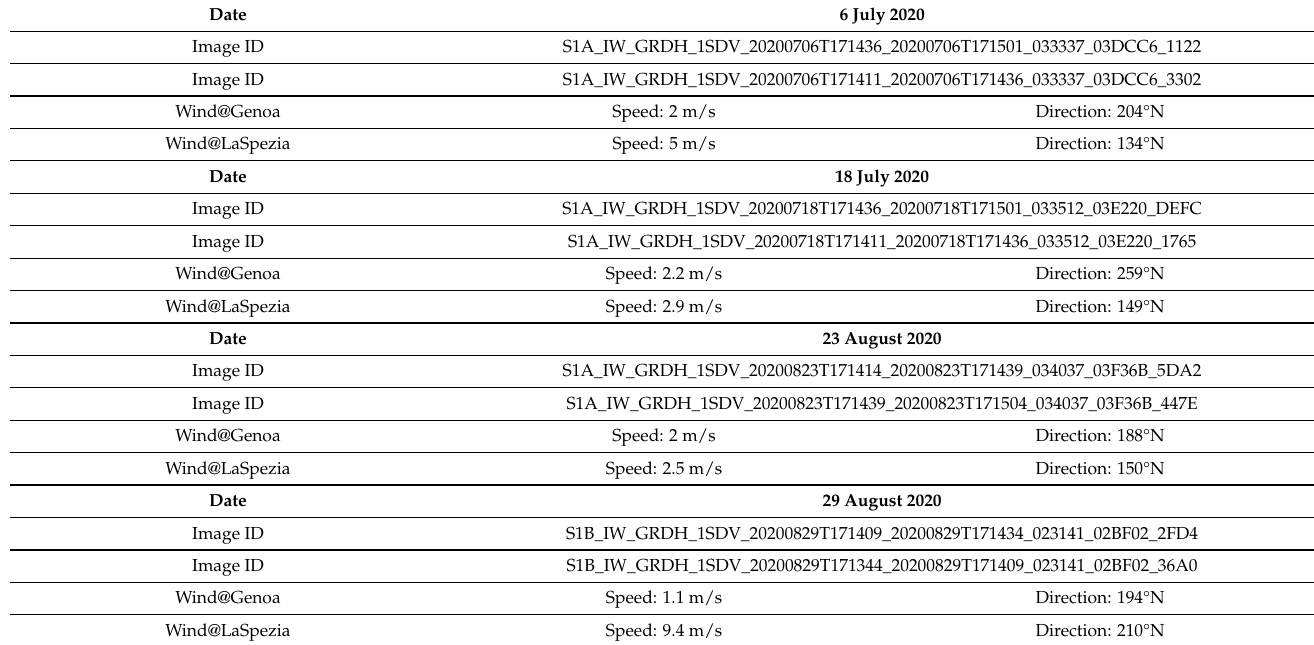
Table 4. List of products under inspection for error